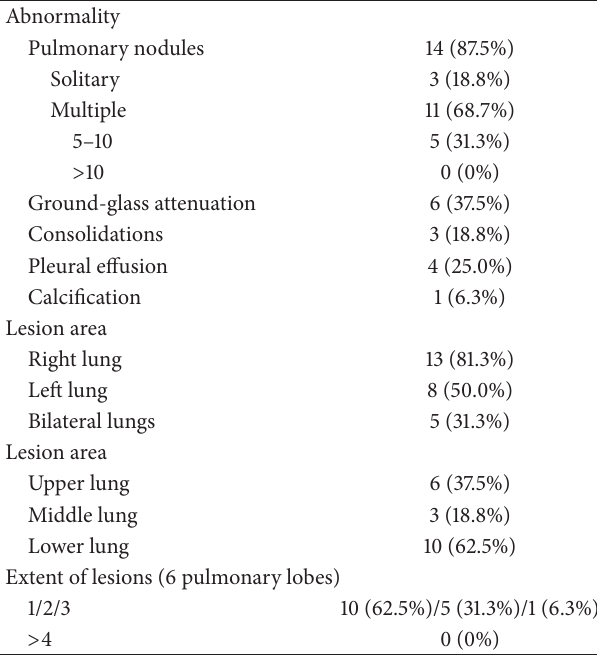
Table 2: Radiological patterns of pulmonary abnormalities of CT